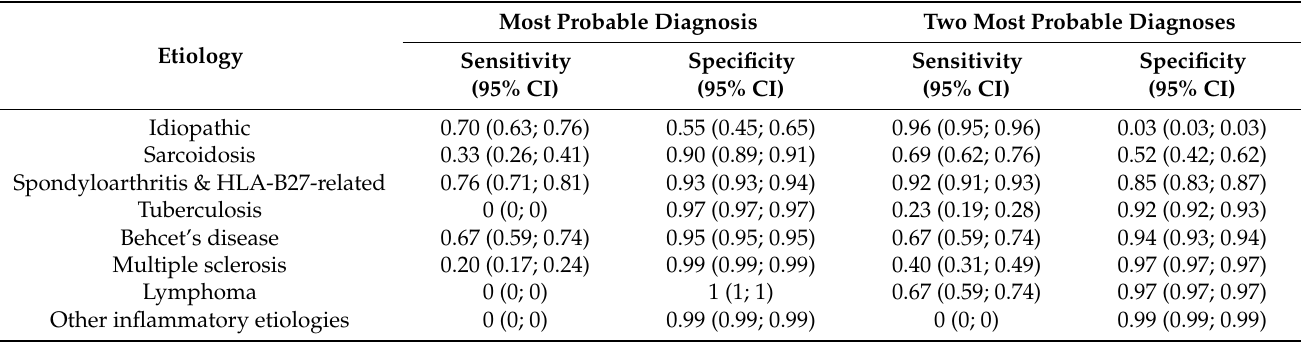
Table 2. Sensitivity and specificity of the Bayesian network to identify the uveitis etiology using the most probable diagnosis and the two most probable diagnoses: estimates based on the Monte Carlo cross-validation carried out in the training